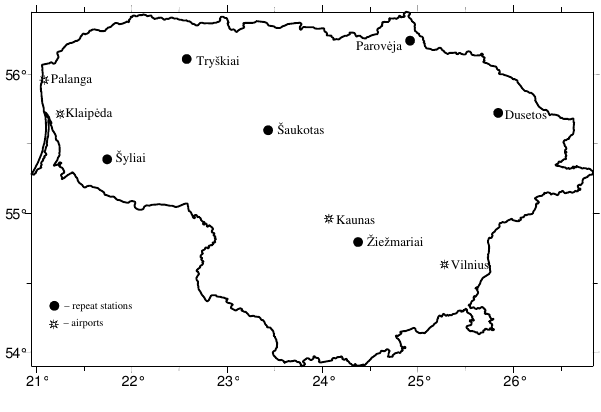
Fig 1. Locations of repeat stations and